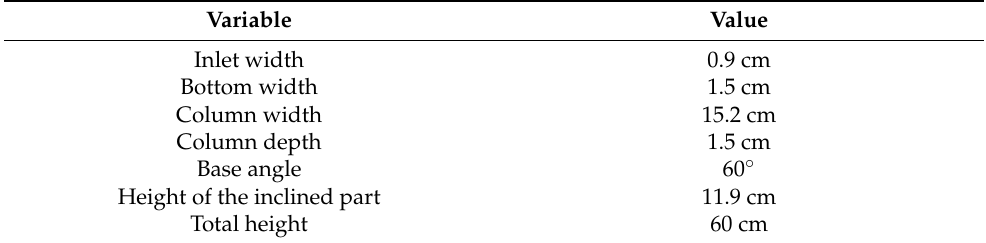
Table 1. Dimensions of the geometry.